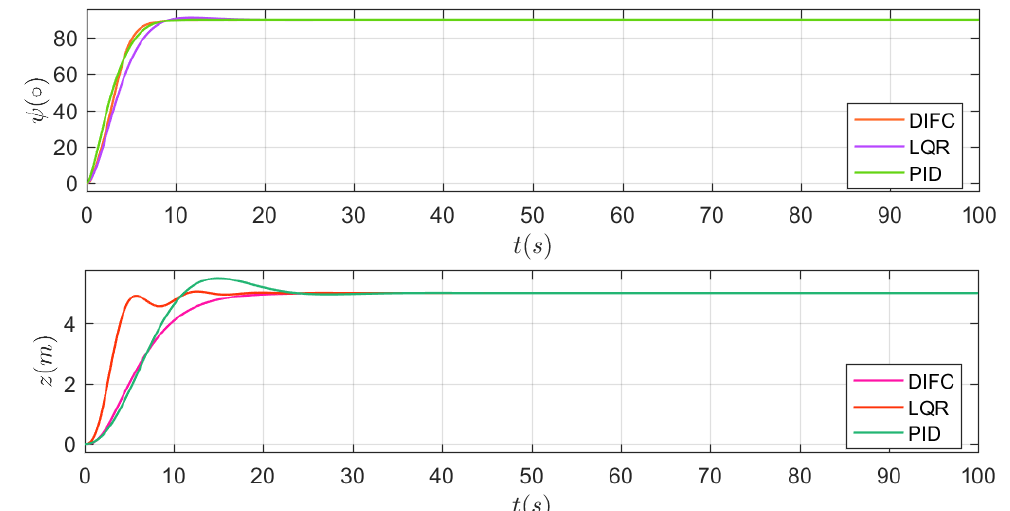
Figure 11. Simulation results when surge velocity is 3 kn. Realtime heading angle ψ during the first scenario (top), and the depth z of the vehicle (bottom).